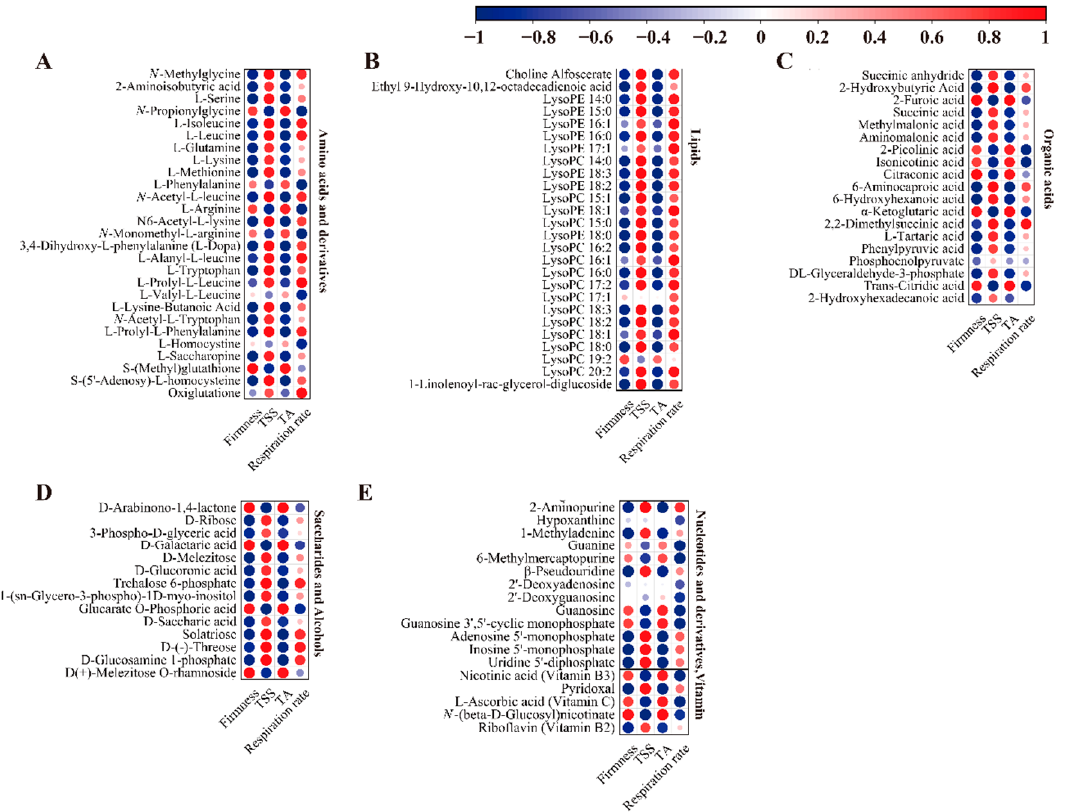
Figure 7. The correlation analysis between physiological characteristics and differential metabolites in ‘Fengtang’ plum fruits: ( A ) Amino acids and derivatives, ( B ) Lipids, ( C ) Organic acids, ( D ) Sac- charides and alcohols, and ( E ) Nucleotides and derivatives,